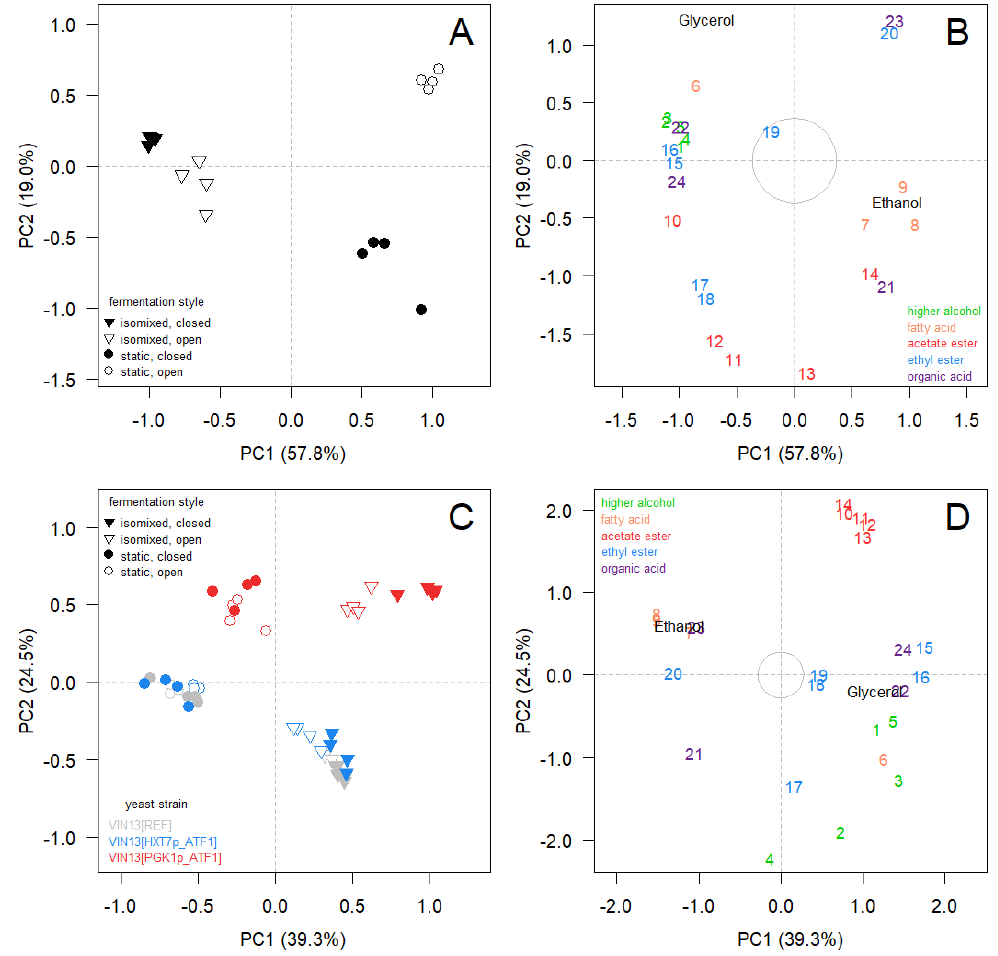
Figure 6. ( A , B ) Distance biplot of Saccharomyces cerevisiae VIN13[REF] fermentations in four different fermentation styles. ( C , D ) Distance biplot Saccharomyces cerevisiae strains VIN13[REF], VIN13[HXT7p_ATF1] and VIN13[PGK1p_ATF1] fermentations in four different styles. Sample ordination and analyte contribution have been separated for better readability. Distances among objects (fermentations) approximate Euclidean distance among them. Analytes (indicated by numbers in panels B and D , which contributed strongly to PC formation, are positioned at increasing distance to the equilibrium circle (grey at the centre). Analytes: higher alcohols isobutanol (1), isoamyl alcohol (2), 2-methyl butanol (3), hexanol (4), phenethyl alcohol (5); fatty acids: isovaleric acid (6), hexanoic acid (7), octanoic acid (8), decanoic acid (9); acetate esters ethyl acetate (10), isoamyl acetate (11), isobutyl acetate (12), hexyl acetate (13), phenethyl acetate (14); ethyl esters ethyl propionate (15), ethyl isobutyrate (16), ethyl butyrate (17), ethyl hexanoate (18), ethyl octanoate (19), ethyl decanoate (20); organic acids acetic acid (21), lactic acid (22), tartaric acid (23), malic acid (24); ethanol (25) and glycerol (26). be meaningful. ATF1 expression modulation resulted in strong separation of fermentations